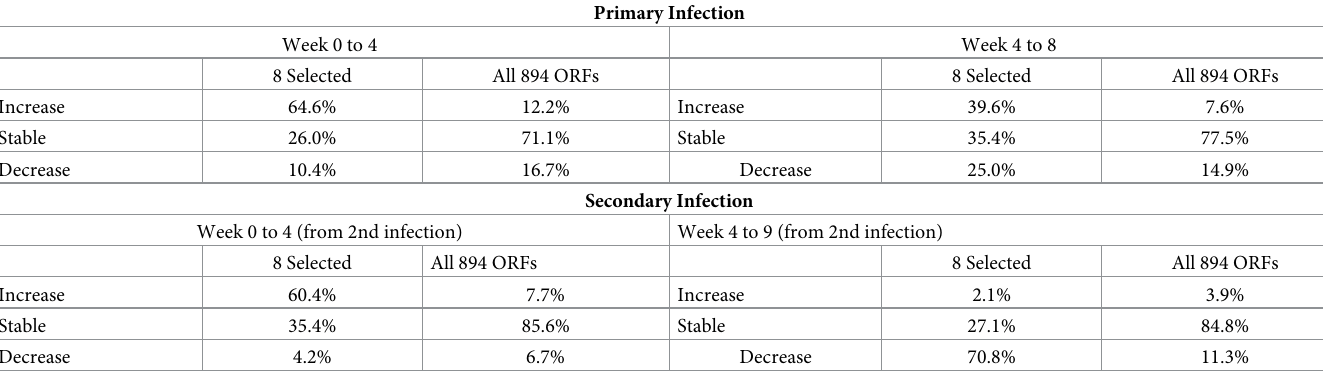
Table 4. Percentages of signals that increase or decrease in consecutive